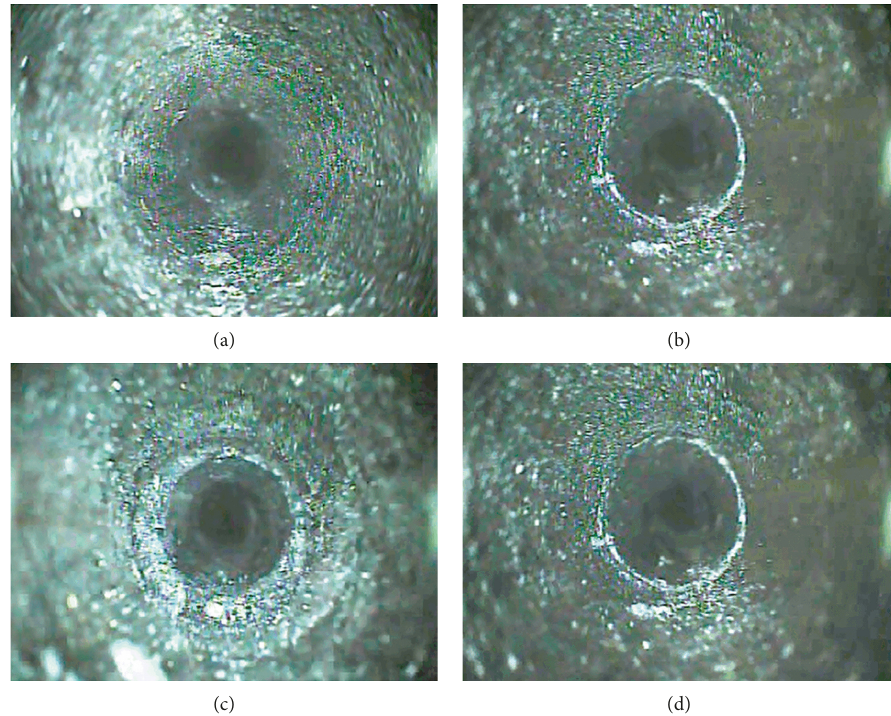
Figure 12: Video capture of the roadway side detection borehole. (a) Complete coal seam. (b) Fracture. (c) Crack. (d)